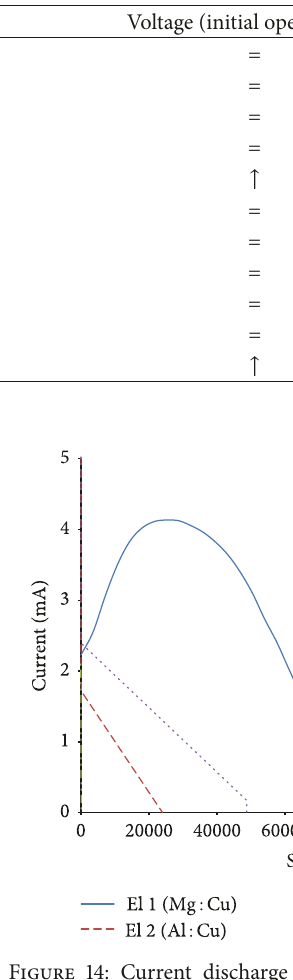
Table 4: Overview of findings.